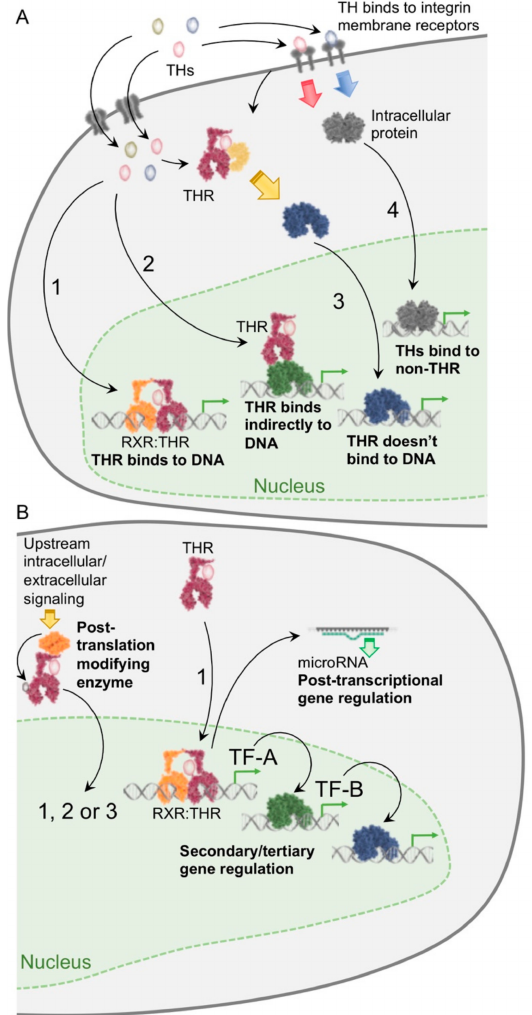
Figure 1. Transcriptional regulation by TH signaling. ( A ) Four major categories of gene regulation by TH